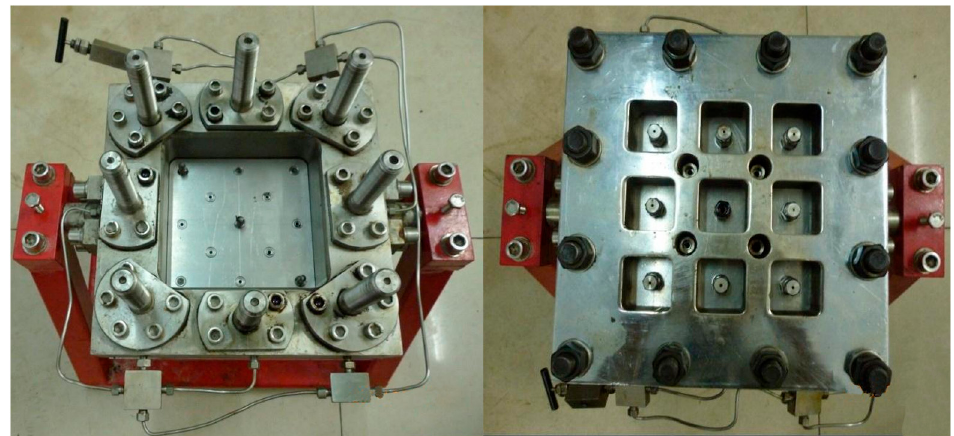
Figure 8. Two-dimensional plate model used in the experiment.